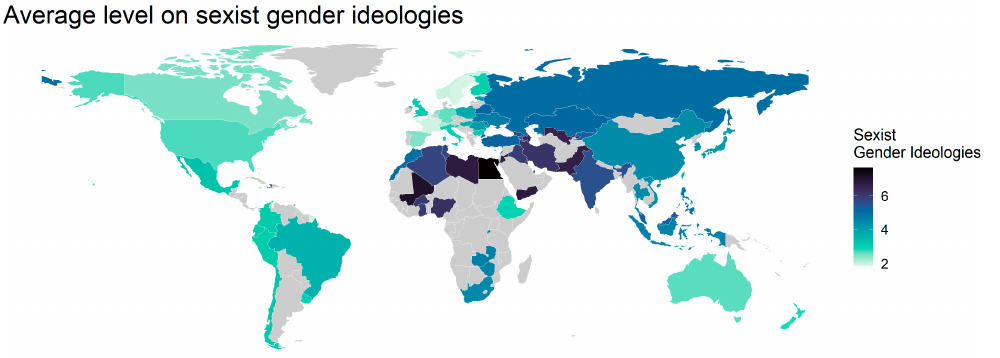
Figure 3. Average levels of the factor scores of the “Sexist Gender Ideologies” scale for the 74 countries included in the analysis. Dark blue indicates holding sexist gender ideologies, and light green indicates a rejection of sexist gender ideologies. Author’s calculations. Source: WVS ‐ EVS data.